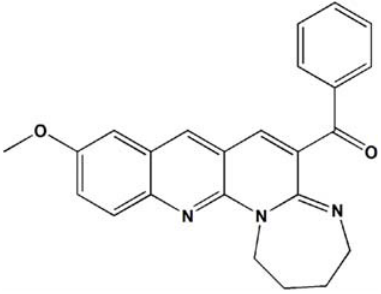
Figure 1. Chemical structure of naphthyridine derivative 3u.